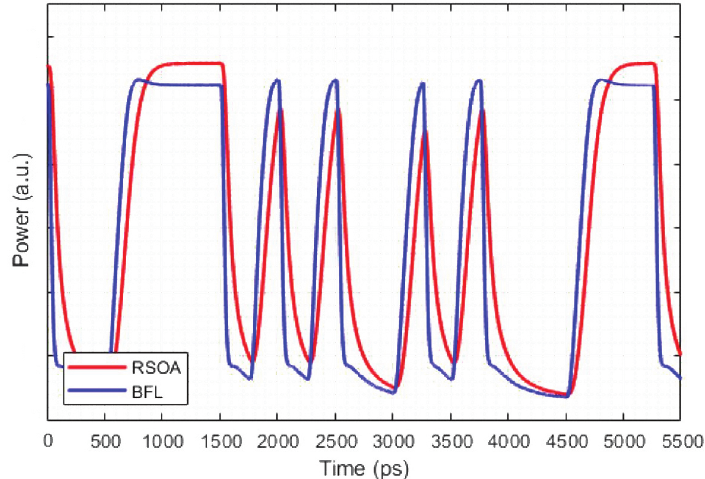
Figure 6. Simulated encoded signal waveforms at RSOA output and BFL output at 4 Gb/s.